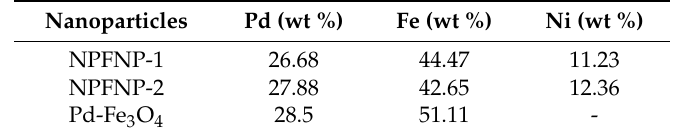
Figure 2. STEM-EDS elemental maps of the NPFNP-2. ( a ) HAADF-STEM image of the particle; ( b – e ) elemental maps for Pd, Fe, Ni, and P, respectively; ( f ) images with overlaid maps.